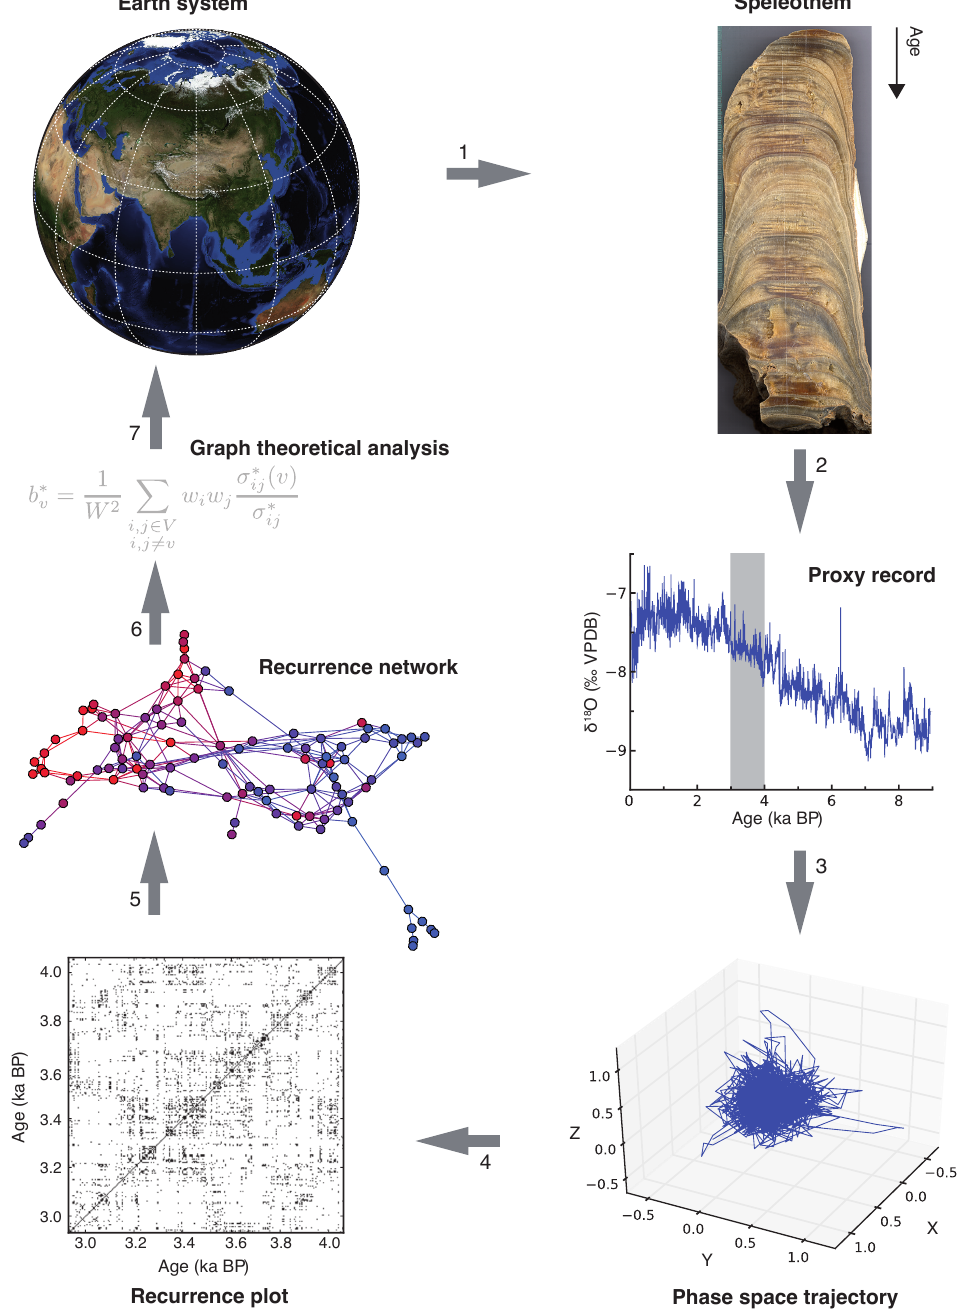
Figure 2. Workflow of recurrence network analysis of palaeoclimate records (here from speleothems). Step 1 indicates the deposition of chemical or physical information on past climate fluctuations in growing speleothems. In step 2, this information is extracted from the speleothem in the form of a proxy record (here, the Dongge DA δ 18 O record; Wang et al., 2005, is used as an example). Subsequently, in step 3, a section of the obtained proxy record (selected time interval indicated by grey bar) is embedded in phase space to unravel the fluctuations induced by variations of the multiplicity of different relevant climatic parameters. In steps 4 and 5, the structure of recurring palaeoclimate states in the proxy record is represented as a recurrence plot and recurrence network (node colour indicates age of palaeoclimate states increasing from red (younger) to blue (older)), respectively. In step 6, the structure of the recurrence network corresponding to a certain epoch is quantified by graph-theoretical measures such as transitivity T or average path length L . Finally, this analysis provides insights into non-linear palaeoclimate variability that can be interpreted taking the underlying Earth system dynamics into account in step 7. The original contribution of this study lies in steps